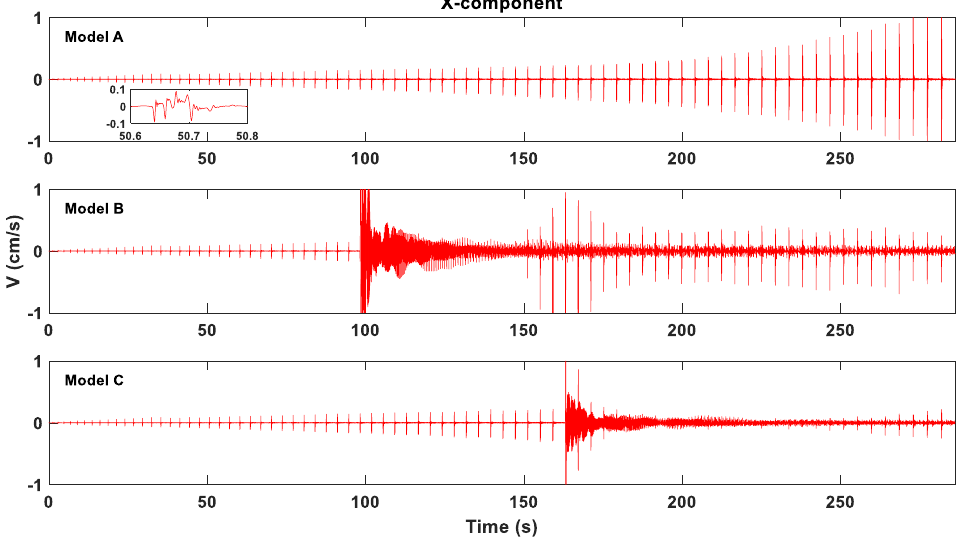
Figure 7—The x-component of the induced microseismicity during hydraulic fracturing. The seismic signals are obtained from the lower first receiver, whose location is shown in Figure 1.